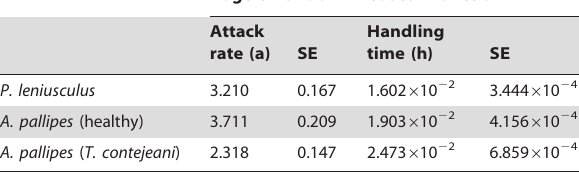
Table 7. Rogers random-predator attack rates and handling times for crayfish functional